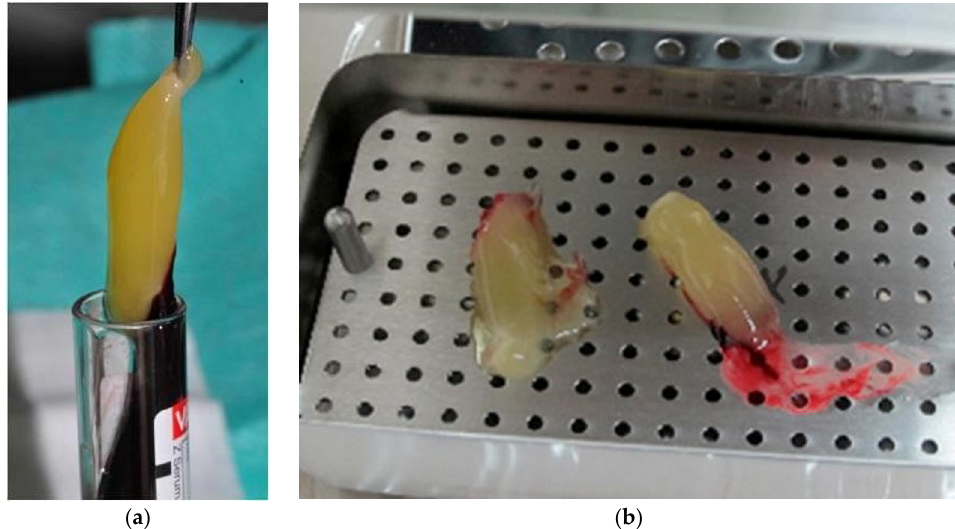
Figure 2. Centrifuged PRF: ( a ) removing the PRF from the test tube; ( b ) PRF separated from red blood cells.